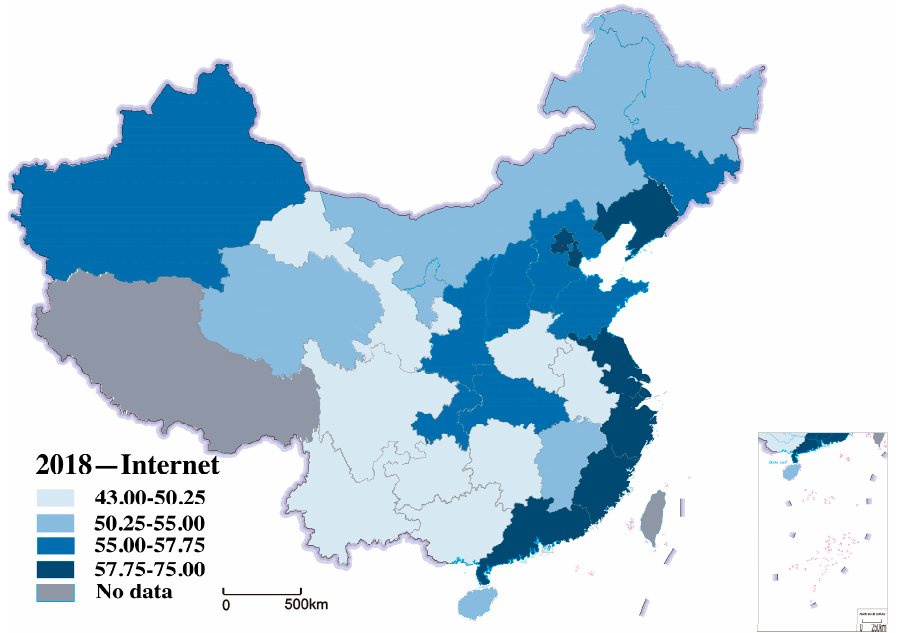
Figure 4. Distribution of Internet development in 2000.